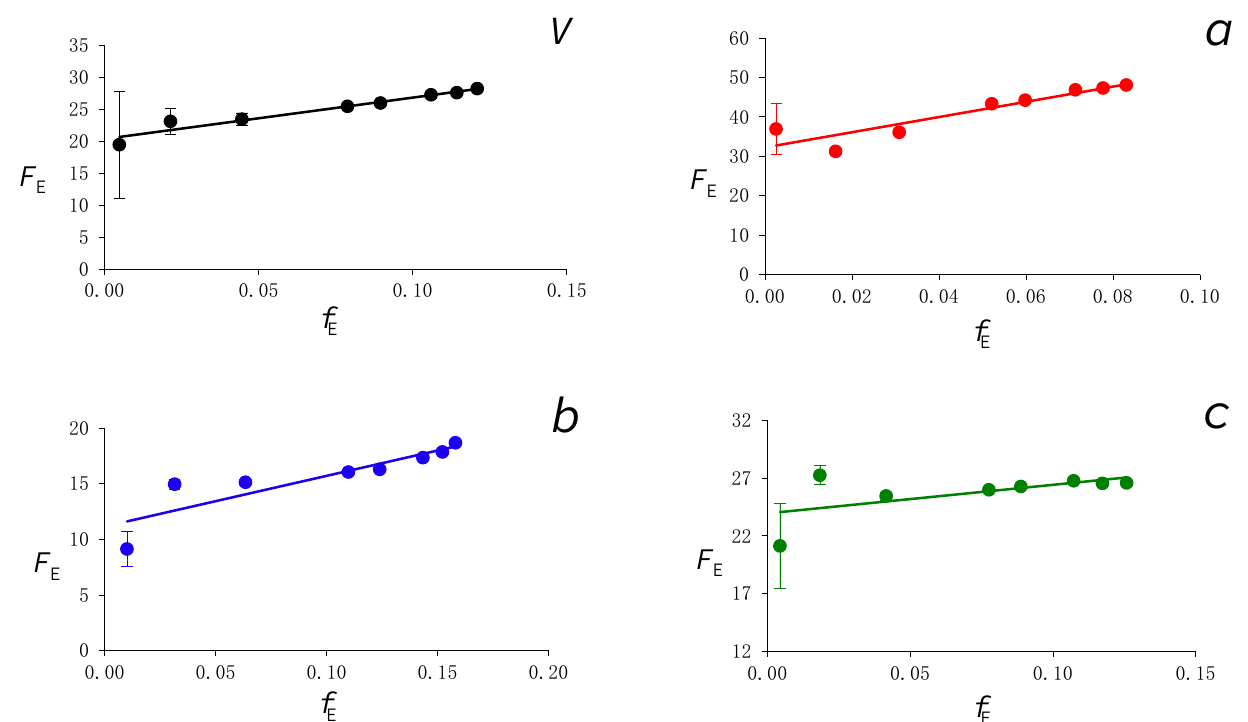
Figure 2. Lattice parameters and volume of mascagnite at different pressures ( a lattice parameter— red dots, b lattice parameter—blue dots, c lattice parameter—green dots, V volume cell—black dots). The values are normalized to the room pressure value to highlight the reciprocal difference in the lattice parameters’ compressibilities.